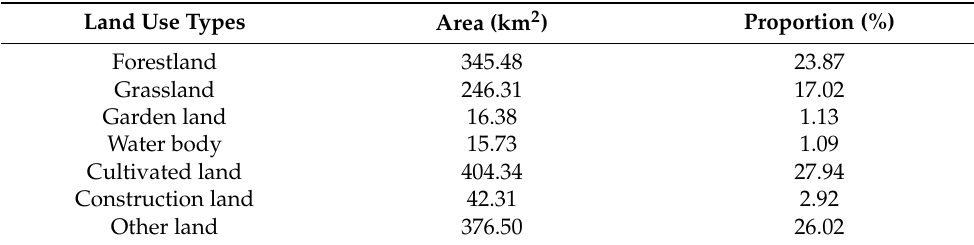
Figure 2. Guanling County land use distribution map. Table 4. Areas of various land use types in Guanling County.